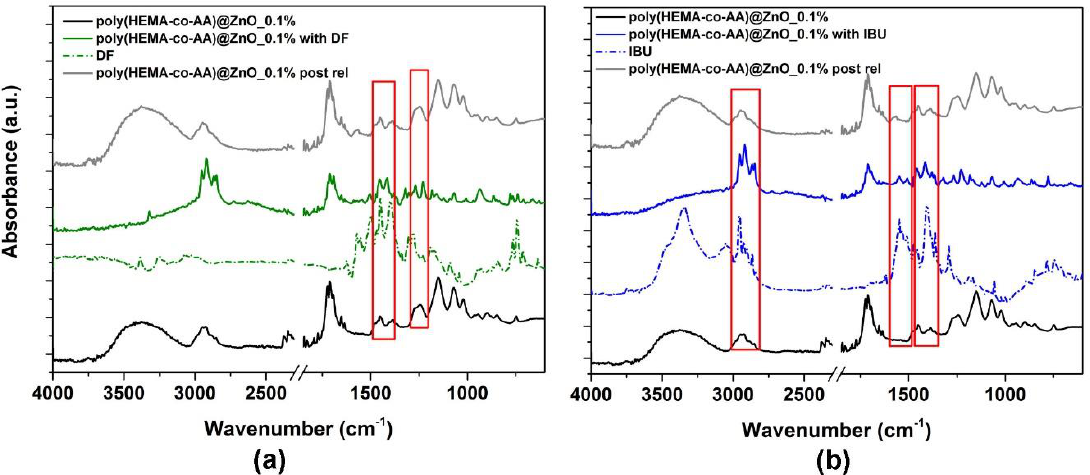
Figure 13. FTIR spectra of poly(HEMA-co-AA)@ZnO_0.1% samples in case of ( a ) Diclofenac release and ( b ) Ibuprofen release.